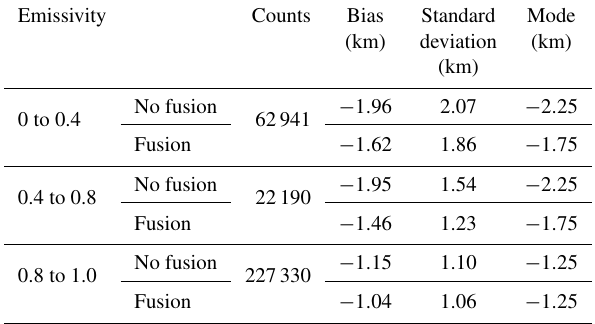
Table 4. Statistics of differences between S-NPP VIIRS cloud top height and CALIPSO-CALIOP using 2 weeks of data in April and October in 2018, when fusion/no-fusion data are used for four emis- sivity ranges. Emissivity is from both ACHA and derived from CALIPSO/CALIOP cloud optical thickness.